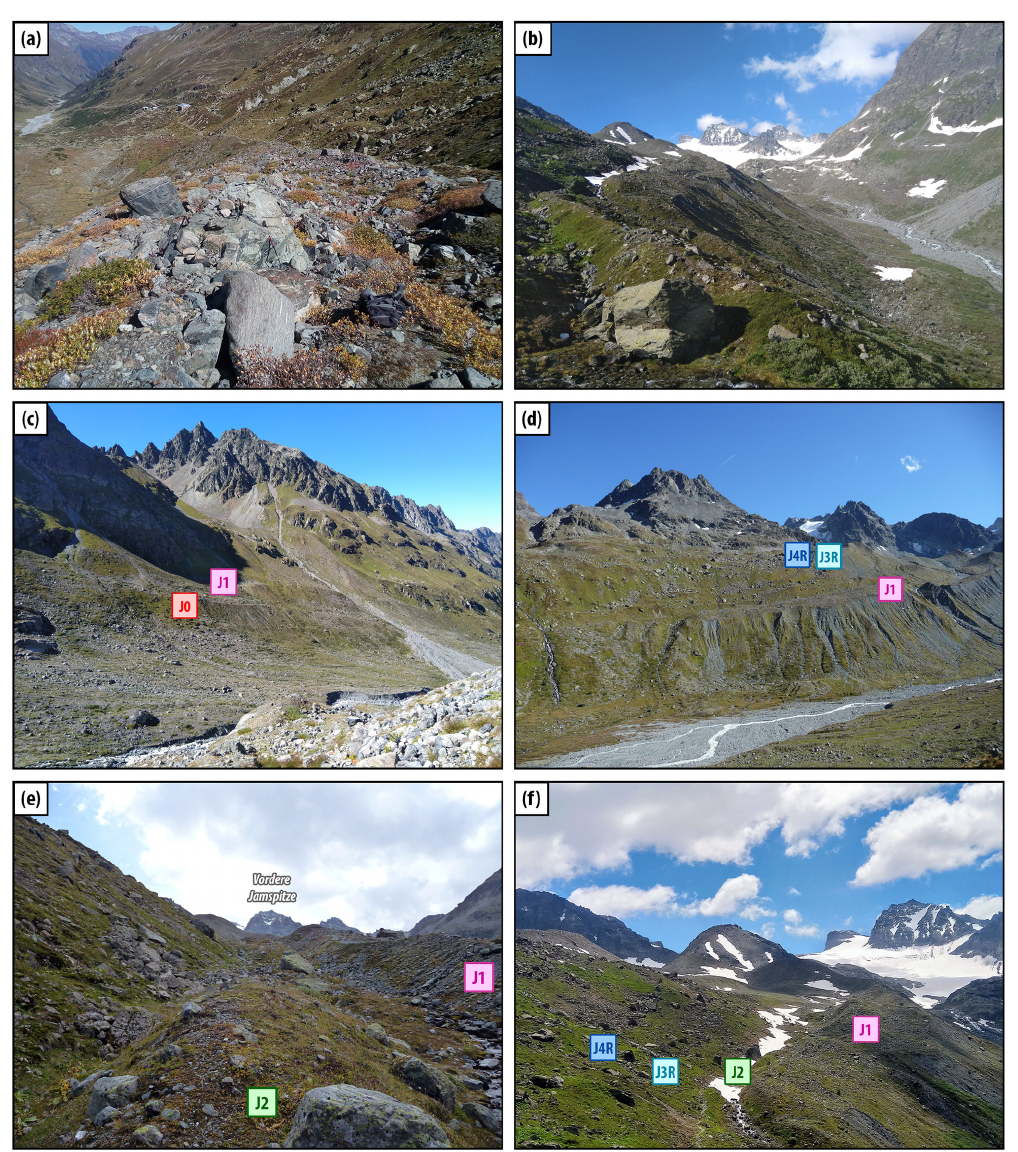
Figure A1. Jamtal. (a) J1 moraine with Jamtal hut in the background. Boulder surfaces are fresh and are not colonized by lichens; pioneer plants are growing on the moraine. (b) J1 multi-ridge structure with view towards with Jamtalferner in the back. (c) Left-lateral side of Jamtal below Totenfeld glacier. (d) View towards Chalausferner (in the background); J1 is in the foreground, J3R and J4R outboard J1 are curved lateral moraines of former Chalausferner. (e) J2 moraine (undated) is at the center with a till-covered slope to the left and J1 to the right. (f) Right-lateral moraine sets. J4R and J3R date to the early Holocene, and J1 is comprised of debris that was deposited during the LIA and during at least one earlier glacier advance around